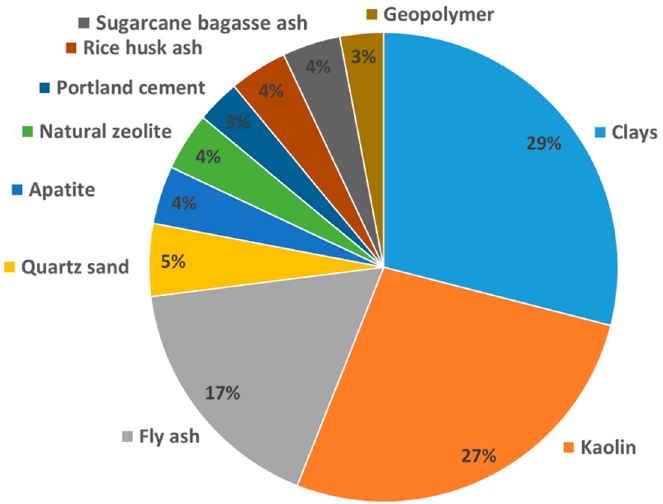
Figure 1. Representation of different raw materials in studies of low-cost inorganic filtration membranes.